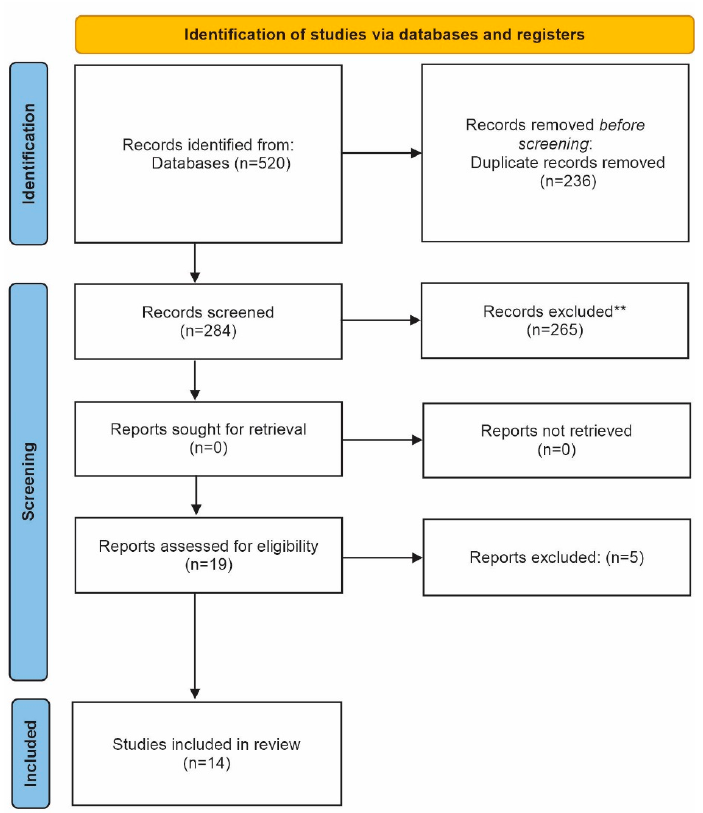
Figure 1. Prisma flow diagram of the selection process of the studies included in the systematic review.